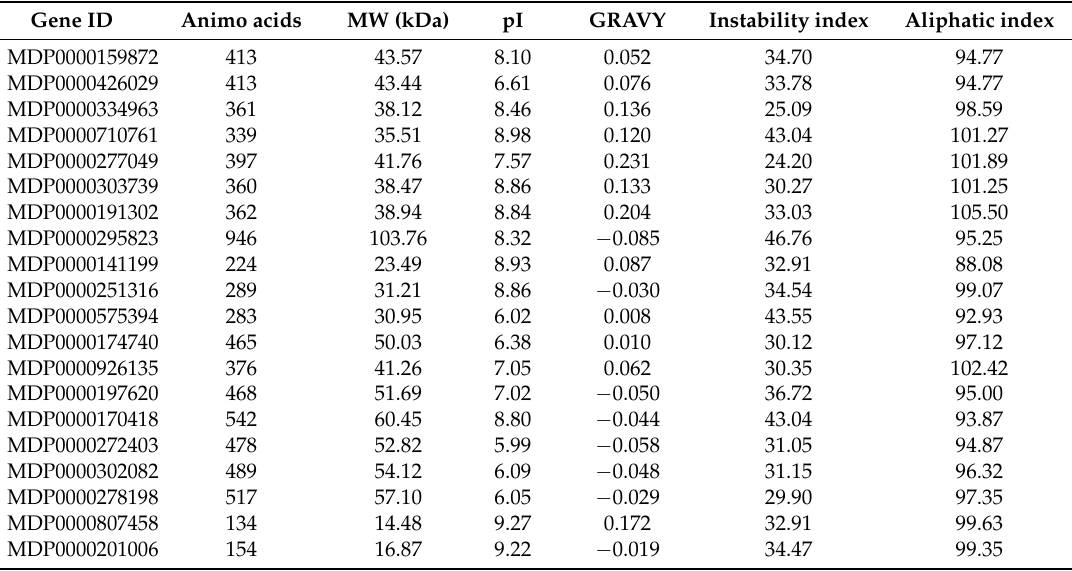
Table 1. Summary information of physiological and biochemical properties of the MdMDH